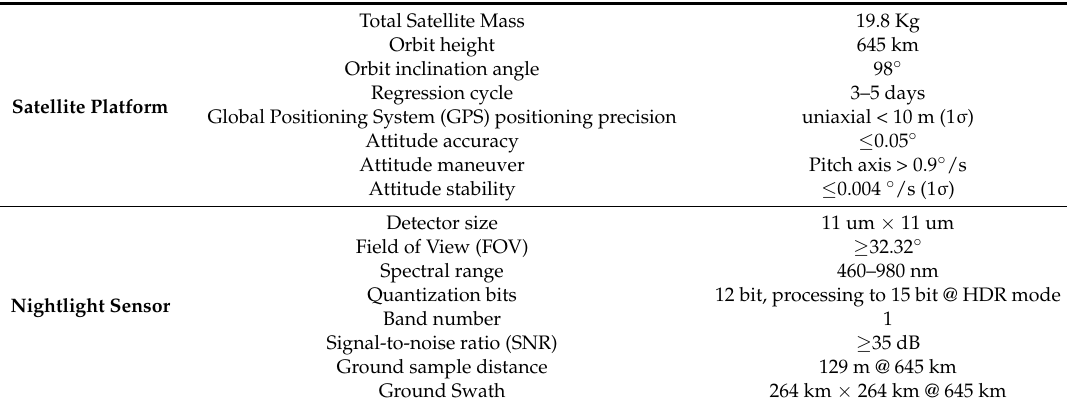
Table 1. Satellite parameters of